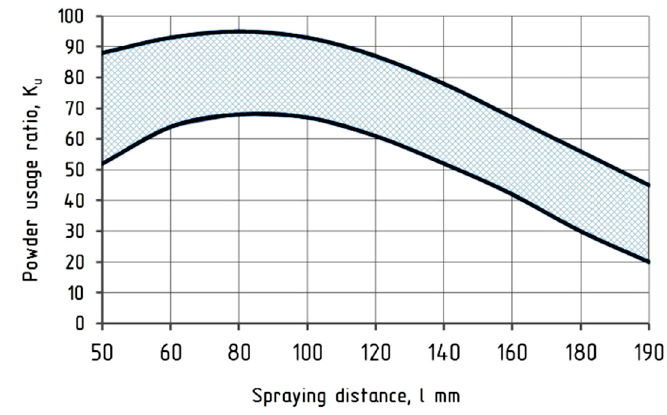
Figure 5. Dependence of the adhesion strength of the coating on the spraying distance l mm at the rotation speed: (1) 55 rpm; (2) 30 rpm, (3) 7 rpm.